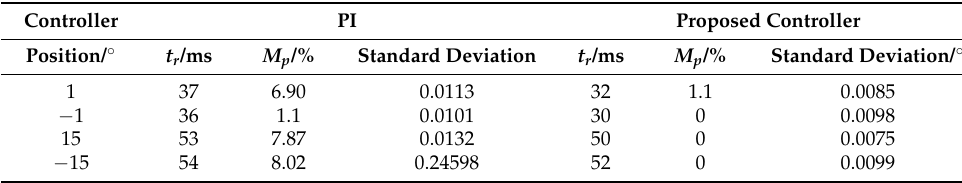
Table 5. Comparison of tracking performance of step